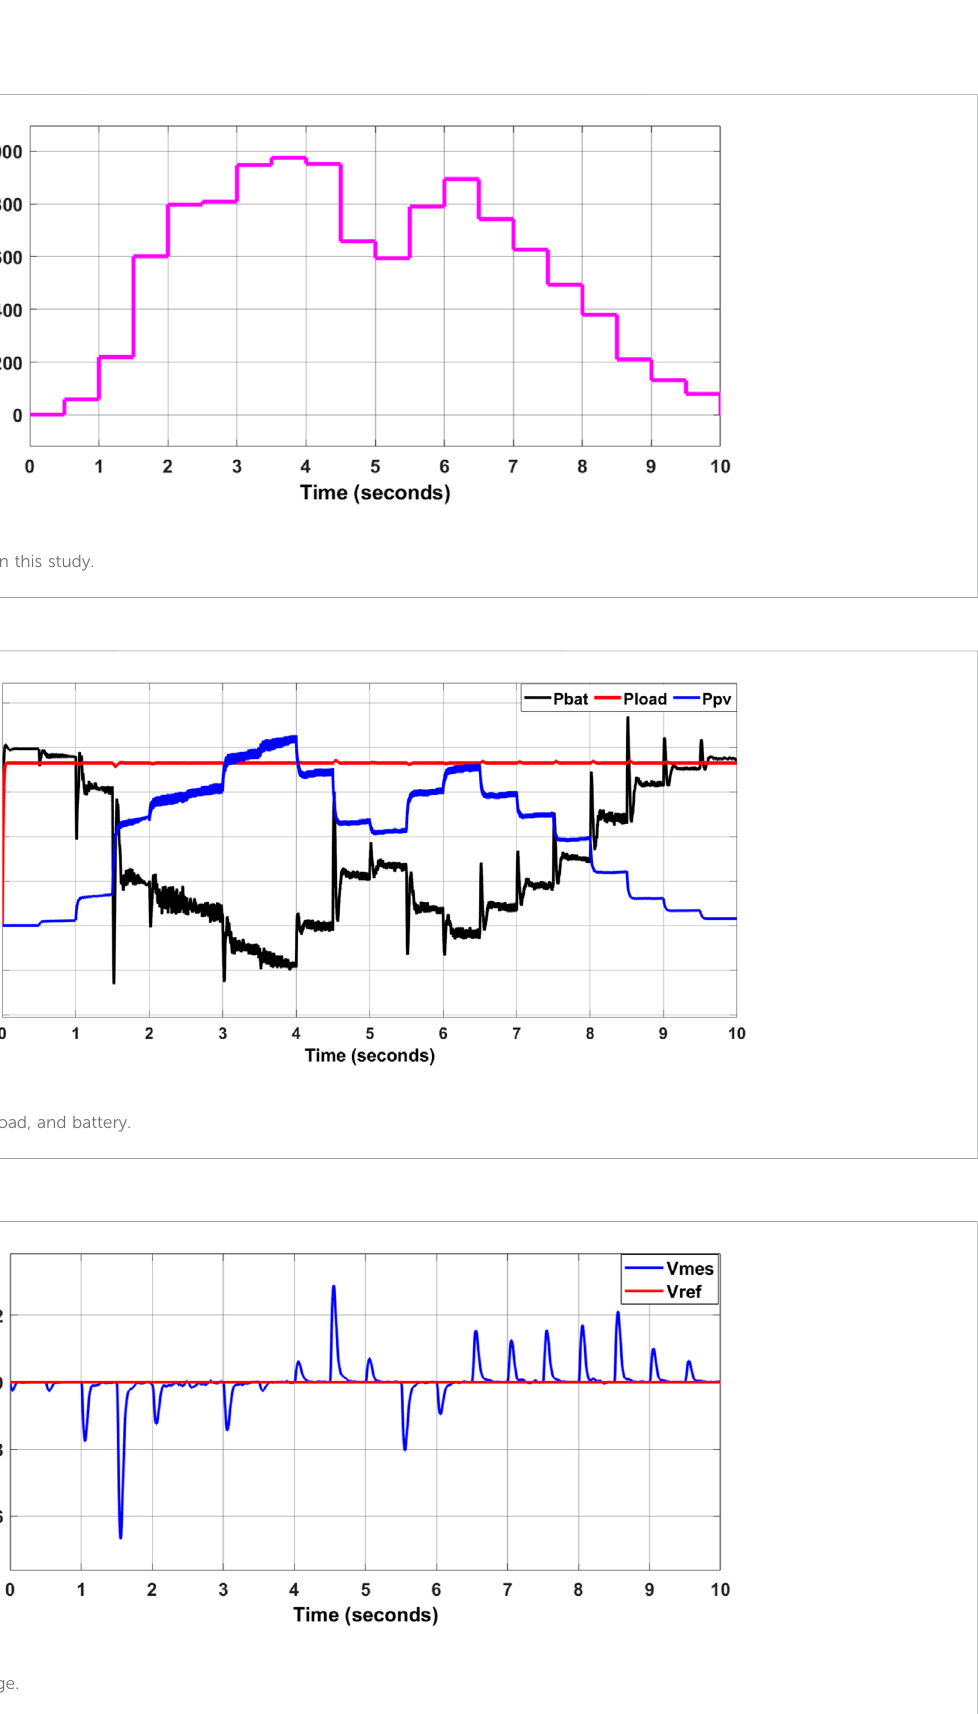
xed from the time of t (cid:1) 0 sec to (cid:1) 1 sec . At this moment, the